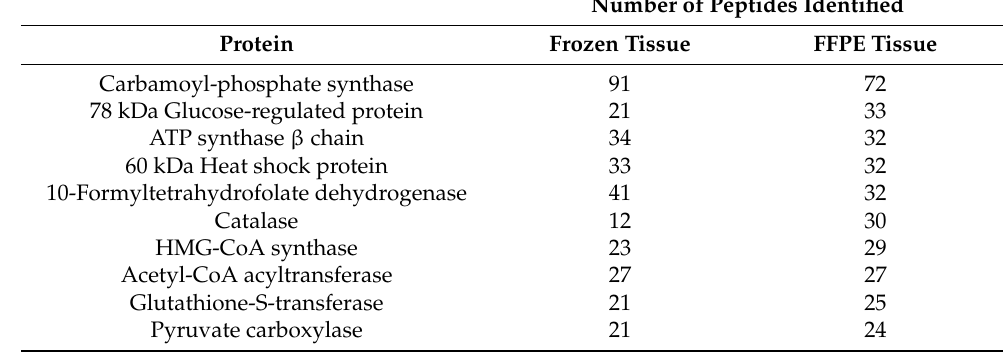
Table 1. Comparison of number of tryptic peptides identified in 10 major proteins identified from frozen and formalin-fixed paraffin-embedded (FFPE) mouse liver tissue. In this study, peptides were extracted from a FFPE and fresh frozen section cut from opposite faces of a mouse liver tissue and identified using mass spectrometry. Number of Peptides Identified Protein Frozen Tissue FFPE